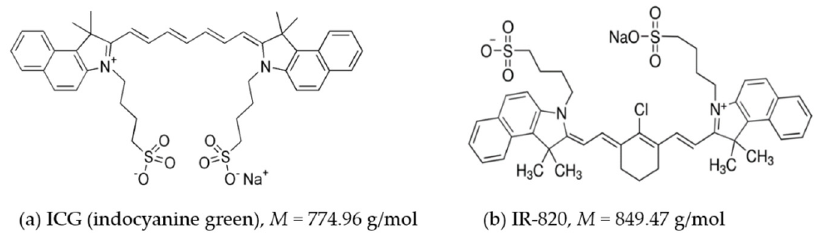
Figure 1. Chemical structure and molecular weight of ( a ) indocyanine green (ICG) and ( b ) IR-820.